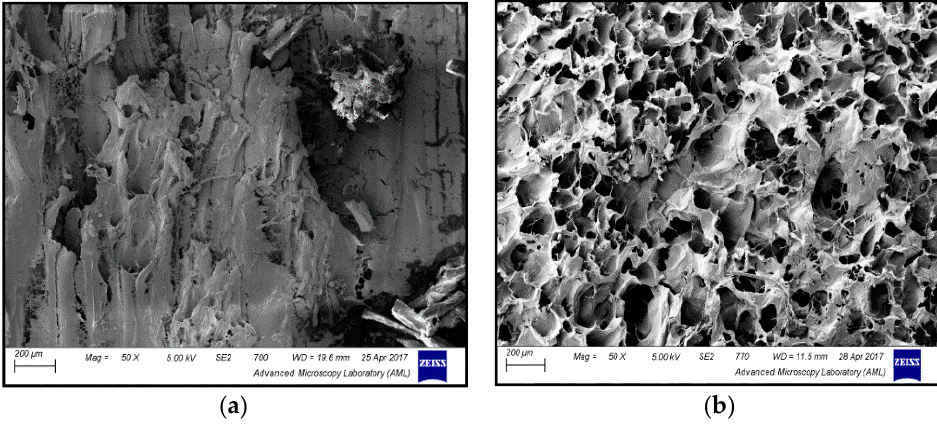
Figure 2. Scanning electron microscopy (SEM) images of pork meat surface subjected to conventional immersion brining, control ( a ) or ultrasound-assisted brining ( b ).